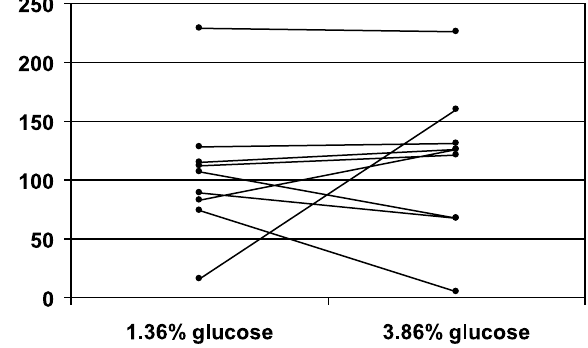
FIG. 2. IL-6 levels after 1.36% and 3.86% glucose used dwells for each